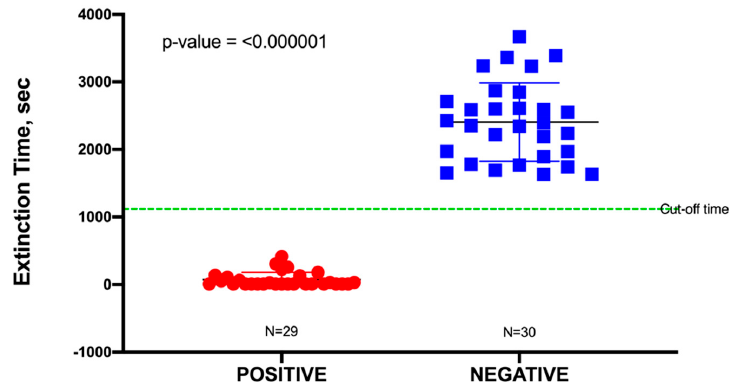
Figure 2. Sample distribution of urinary tract infection (UTI) negative and positive samples